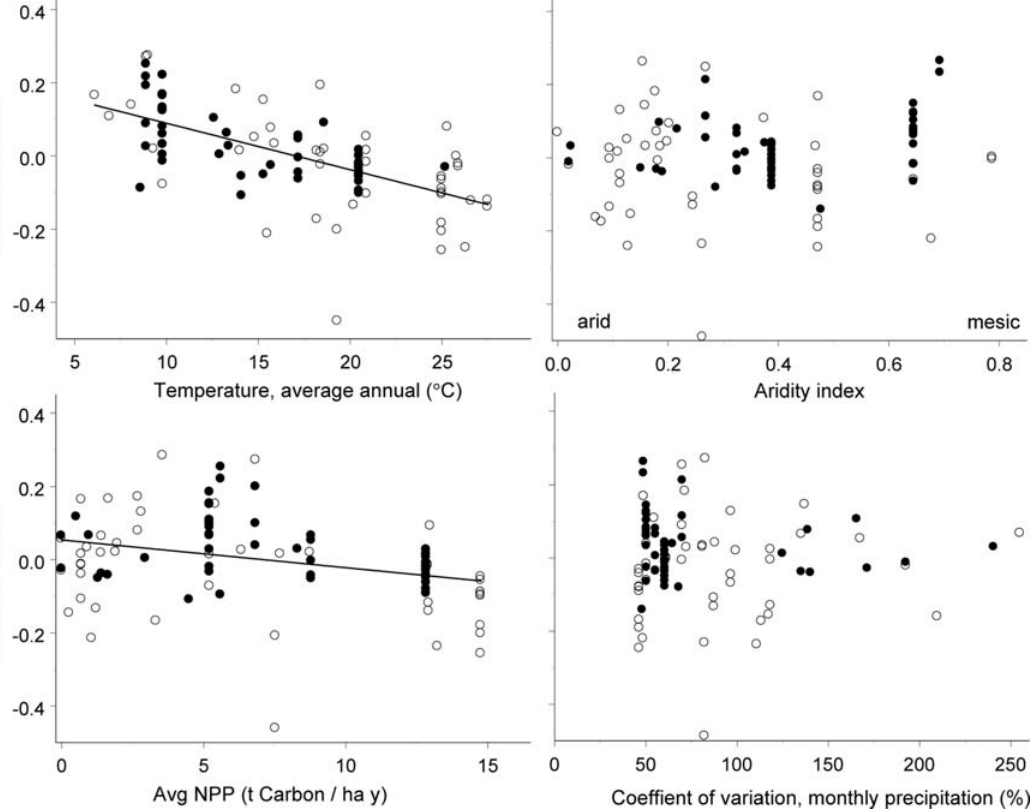
Figure 2. Partial residual plots of core environmental correlates of BMR for the combined dataset of both migrant (black circles) and non-migrant birds (open circles). Each panel shows the effect of a single predictor on BMR controlled for body size and Pass/non-p membership. Regression lines are those significant for combined non-migrant – migrant data (Table 2). Negative residual outlier ( ,2 0.4 partial residual value) is the group-living Green Woodhoopoe ( Phoeniculus purpureus